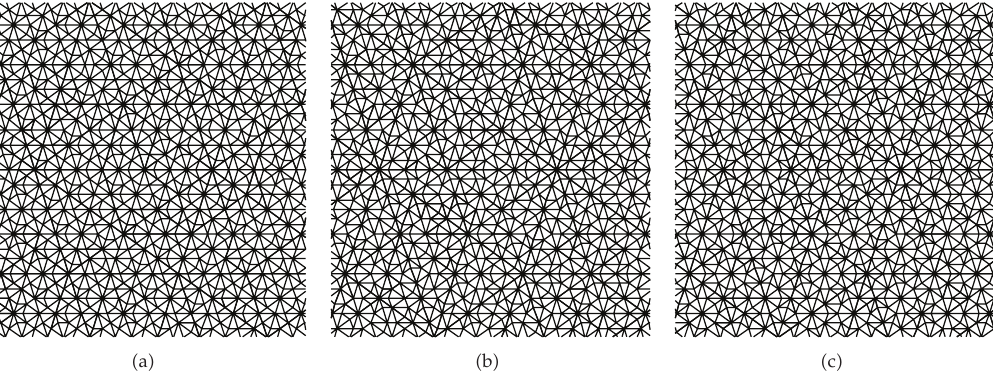
Figure 3: Fragments of (cid:6) a (cid:7) T − , (cid:6) b (cid:7) T (cid:8) and (cid:6) c (cid:7) Penrose tilings.